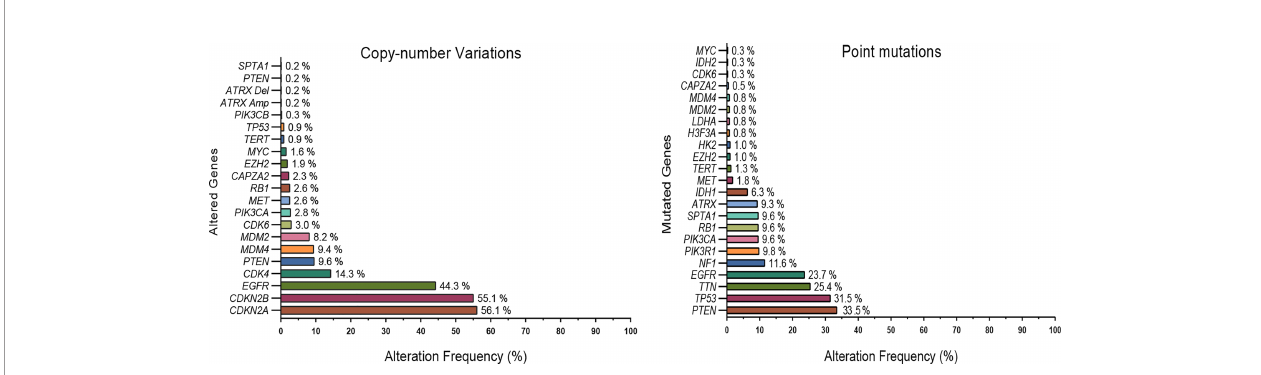
FIGURE 1 | Commonly mutated genes and copy number variations in GBMs. Data (592 patients) from the TCGA dataset (Glioblastoma multiforme; TCGA- PanCancer Atlas) were explored using the cBioPortal platform. For clarity, only a subset of highly altered and metabolic genes are shown. EGFR, PTEN, TERT , and several metabolic genes such as IDH 1/2 , HK2, MYC, LDHA, EZH2 were frequently altered in